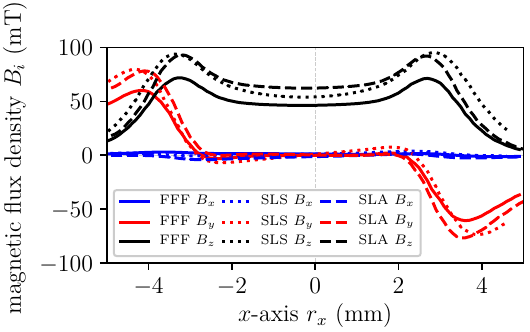
Figure 5. Line scan of the magnetic flux density B , 2.5 mm above the pyramid tip (T).